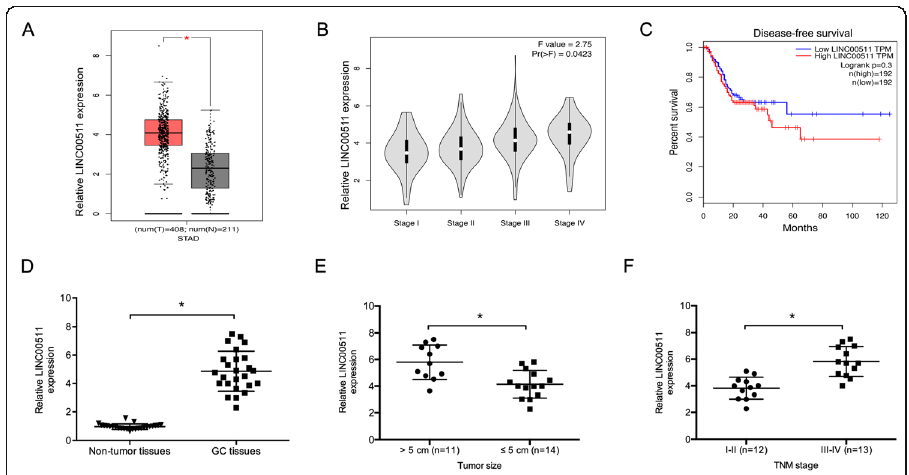
Fig. 1 The LncRNA LINC00511 is upregulated in gastric cancer. a and b The relative LINC00511 expression in gastric cancer tissues, based on the TCGA dataset. c Disease-free survival analysis based on the TCGA dataset. d LINC00511 expression in 25 paired gastric cancer tissues was evaluated using quantitative RT-PCR. e and f High levels of LINC00511correlated with larger tumor size and advanced TNM stage in GC patients. * p < 0.05. Individuals were separated into two groups based on median gene